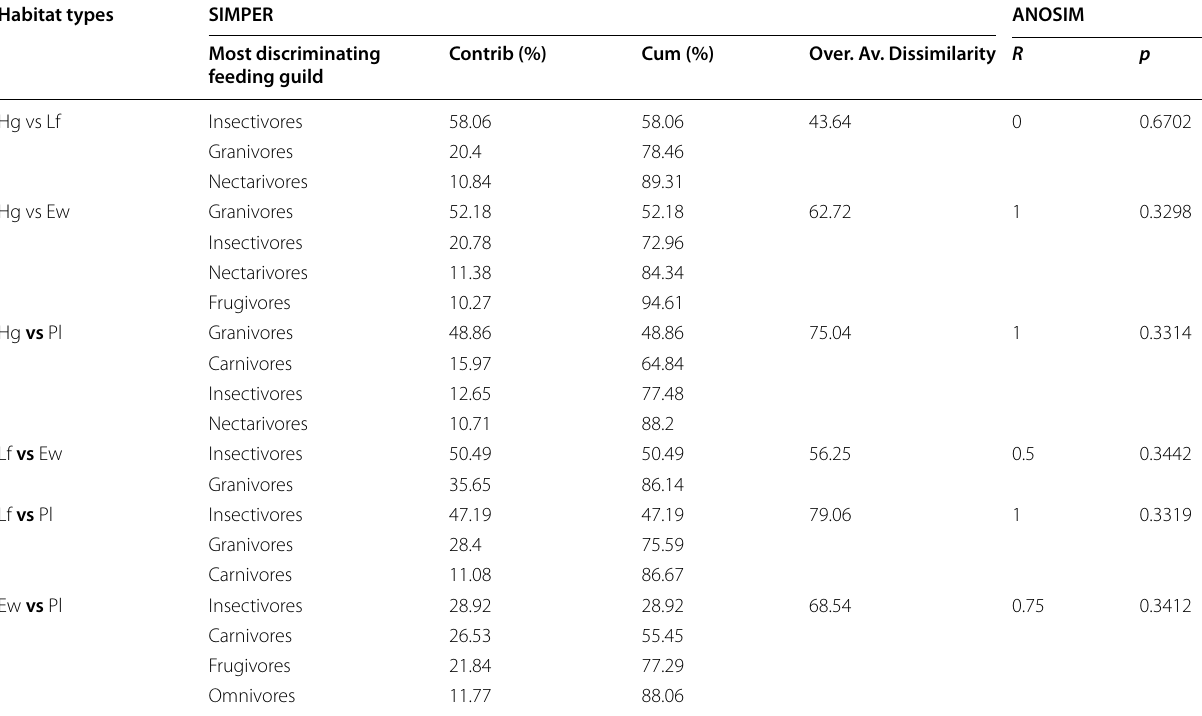
Dissimilarities between pairs of groups and bird feeding guild contributions are indicated. The average dissimilarity is the contribution of each feeding guild to the dissimilarity between the two groups according to Bray-Curtis similarity. Contribution % indicated the contribution of each feeding guild to the group pair dissimilarity in percentage values. Cumulative % indicates the cumulative value of the contribution of each feeding guild to the dissimilarity. Only functional feeding groups that contributed the most (> 10%) to the dissimilarity are shown Contrib% Percentage contribution, Cum % Cumulative contribution, Over. Av Overall average dissimilarity, R Global R -value, P-value Significant value < 0.05